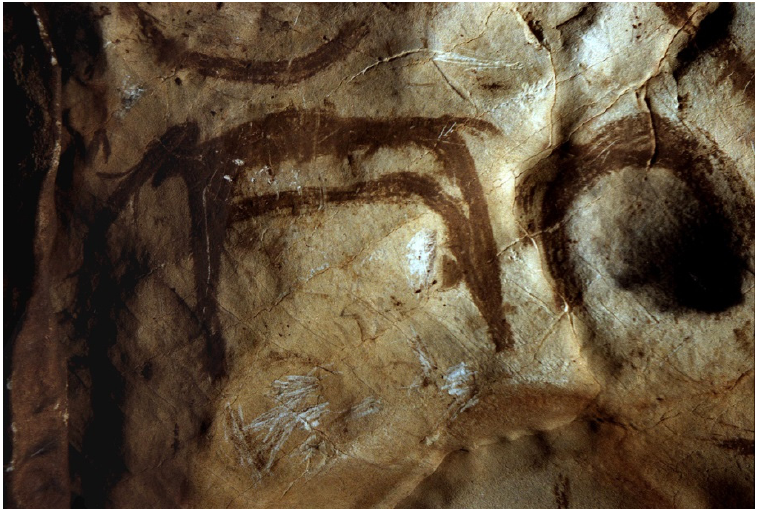
Figure 15. Finger paintings of zoomorphs made with clay on the ceiling of Baume Latrone; the image was taken in 1981, before the traces of vandalism were